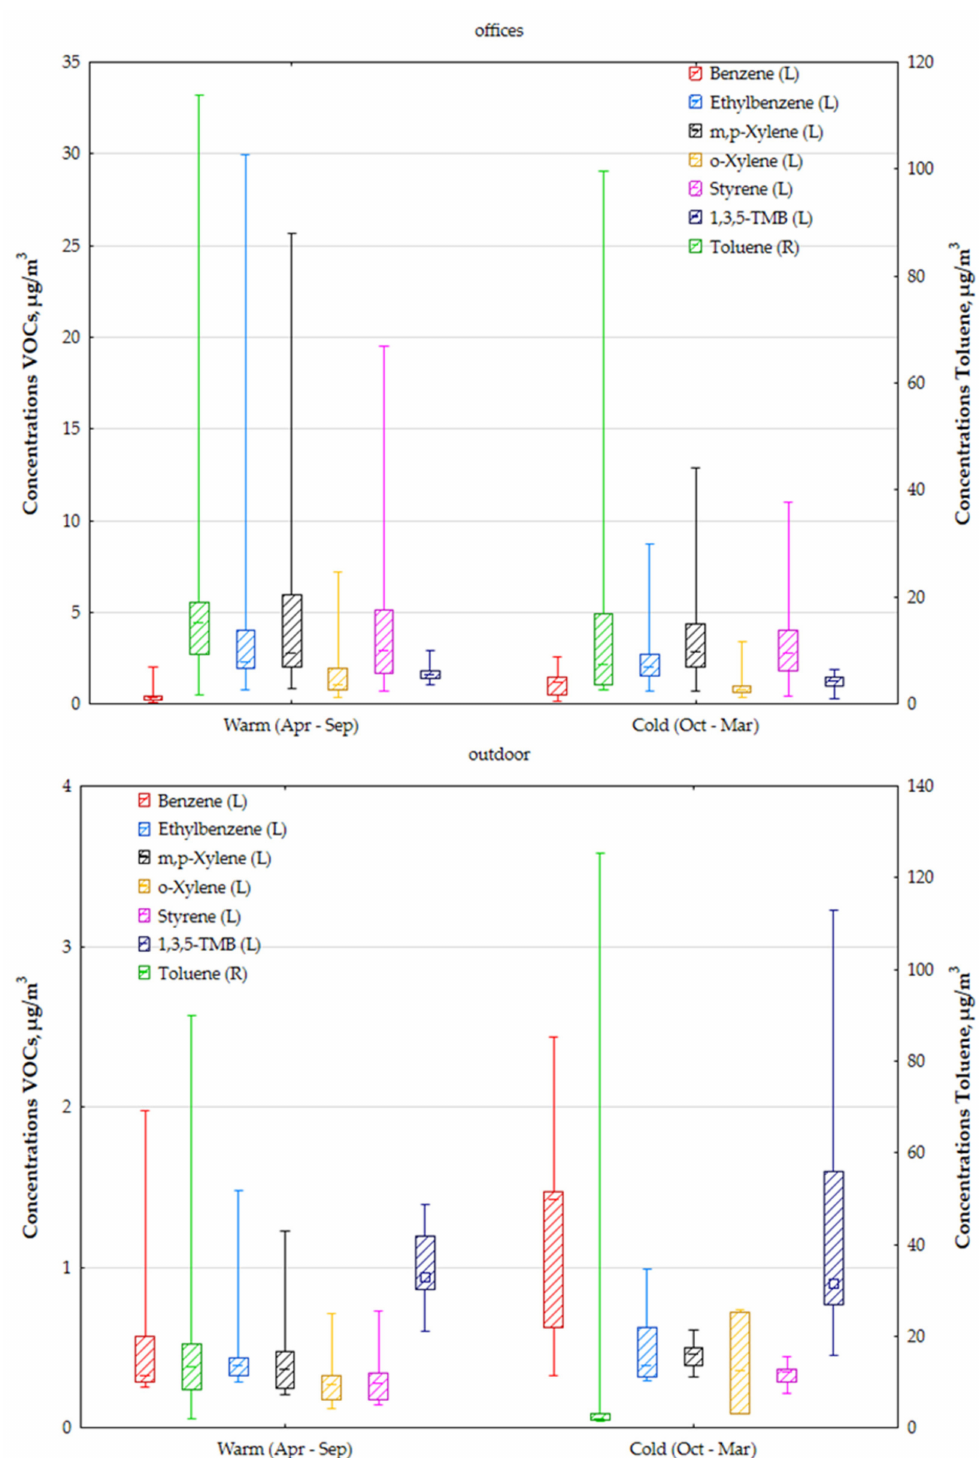
Figure 2. Box-whisker diagram for concentrations obtained in two measurement seasons, where: the central point—the median, the box (25th Percentile, 75th Percentile), whisker—the range